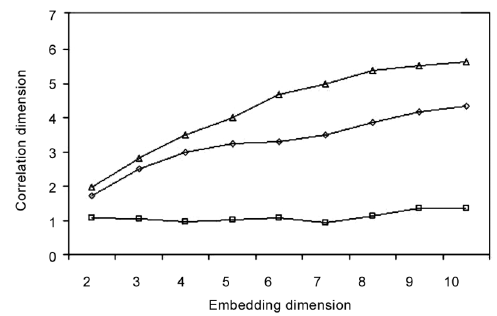
Fig. 5. Correlation dimension versus embedding dimension of differenced waiting times sequences (complete catalogue): diamonds – before experi- ments; squares – during experiments (1983-1988); triangles – after